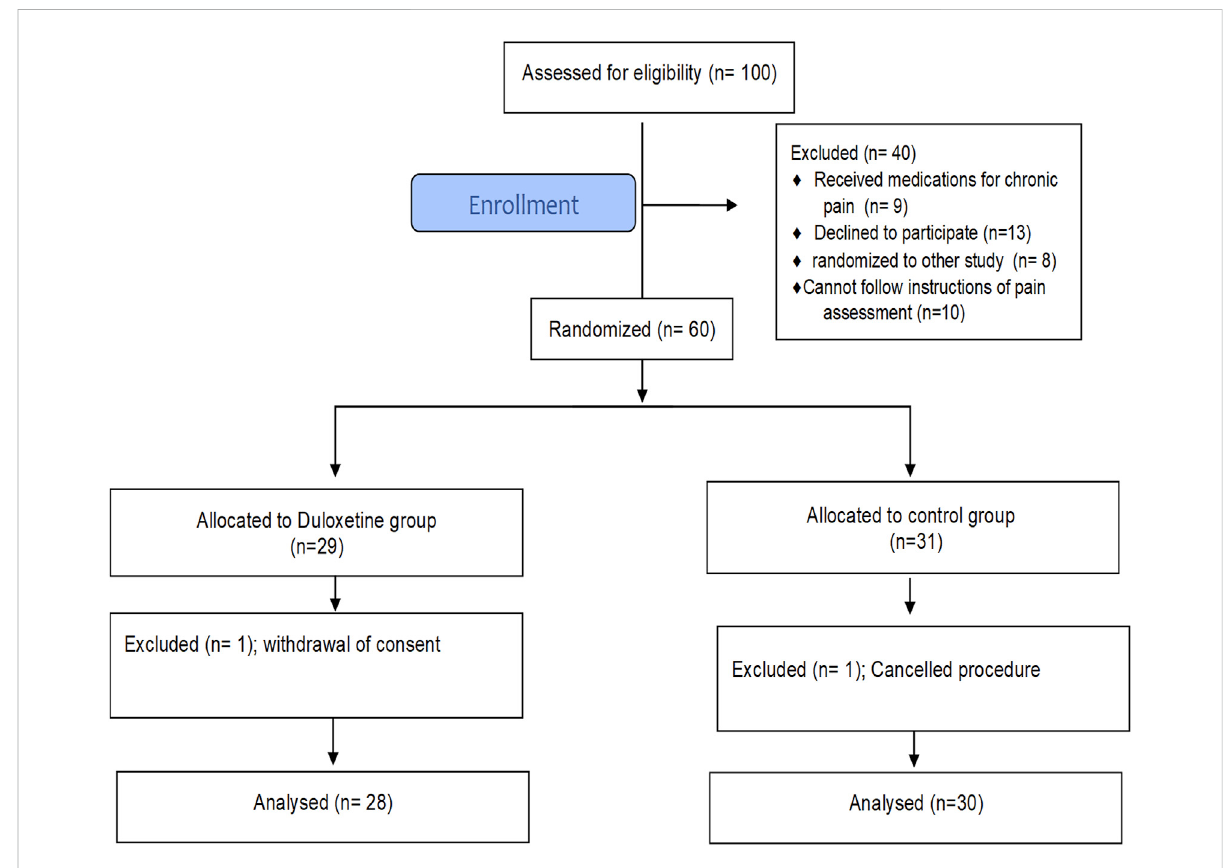
FIGURE 1 CONSORT fl ow diagram showing the fl ow of patients throughout the